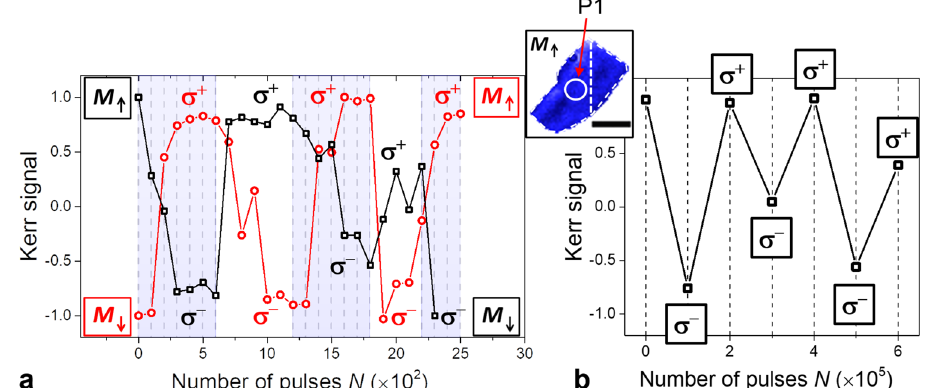
Fig. 3 | HD-AOS within circular region P1 in the center of the heterostructure CrI 3 (10nm)/WSe 2 (1L) (sample 2). a HD-AOS induced by N bunches of 10 2 pulses withcircularpolarizationalternatingbetween σ + and σ − .Theplotshowstheeffectof the optical pumping for two different initial remanent states, M ↑ (black squares) and M ↓ (red circles). b HD-AOS for N bunches of 10 5 pulses alternating between σ −